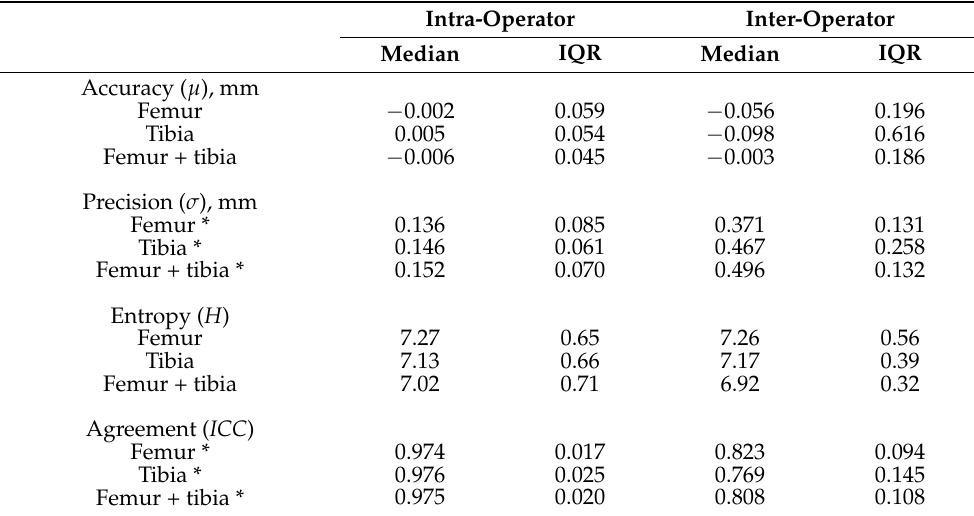
Figure 2. Bland-Altman (first column) and scatter (second column) plots of a typical femur for the intra-operator (first row) and inter-operator (second row) conditions. These four graphs are based on the 5512 pixels of the femoral 2D anatomically standardized map. In the Bland-Altman plots, the continuous lines represent the accuracy, while the dashed lines represent the precision. The black lines in the scatter plots correspond to the identity line. Table 1. Intra- and Inter-Operator